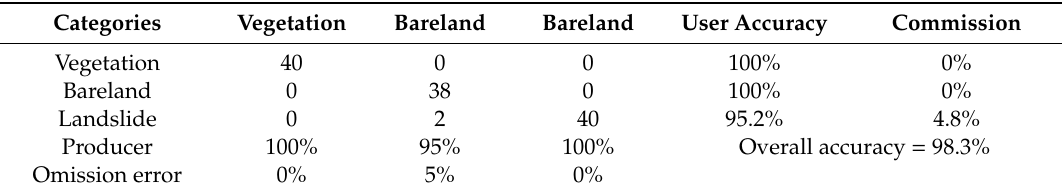
Figure 8. The thematic of support vector machine (green: vegetation, red: landslide and white: bareland). Table 2. Error matrix for